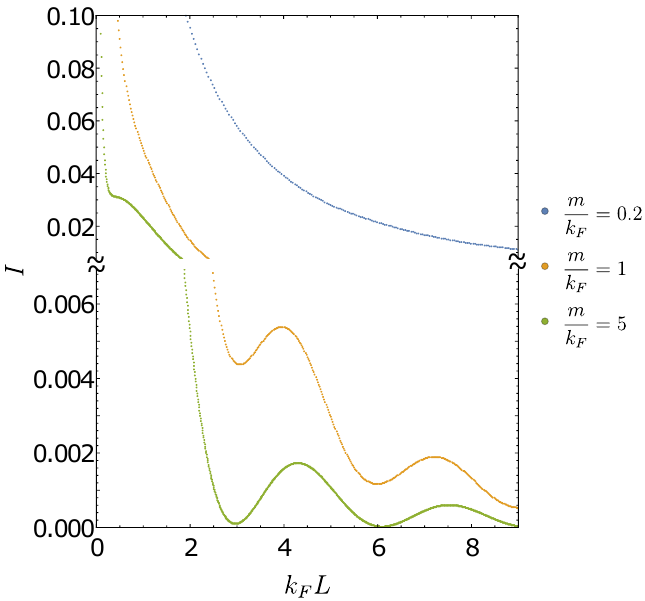
Figure 7 . I ( k F L ) for fixed r for massive Dirac fermions at finite density. The lengths r were k F r = 2 , k F r = 0 . 5 and k F r = 0 . 2 for m period π as function of k F L are present. Their amplitude vanishes when m/k F → 0